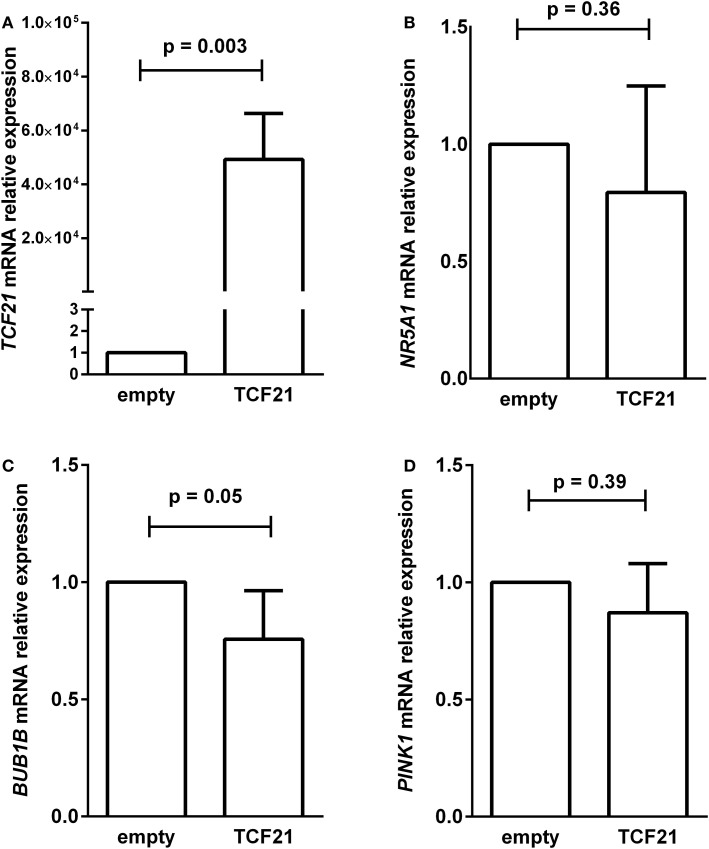
RT-qPCR analysis to determine the relative gene expression of (A)
TCF21 [95% confidence interval (CI) = 27,888 to 70,495], (B)
NR5A1 (CI = −0.77 to 0.36), (C)
BUB1B (CI = −0.50 to 0.01), and (D)
PINK1 (CI = −0.65 to 0.39) in H295R cells transiently transfected with an empty vector pCMVMyc (empty) vs pCMVMycPod1 (TCF21). Statistical significance was assessed by paired T test on three to five pairs.